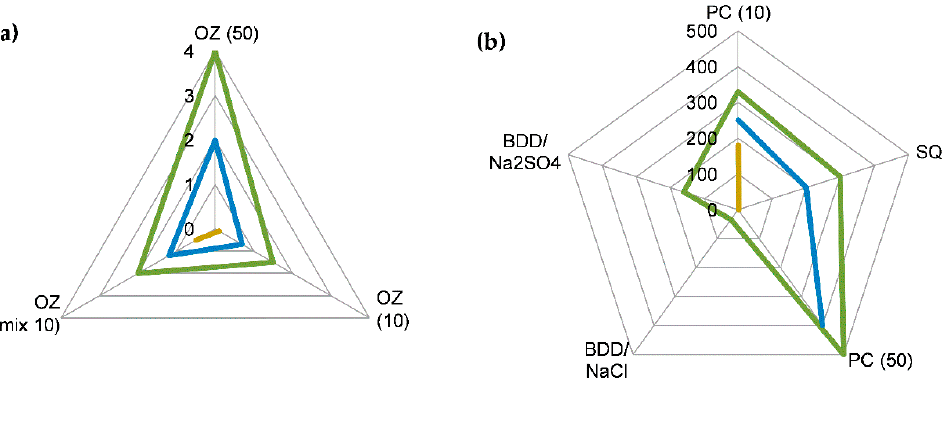
Figure 1. Treatment time for reaching > 95% removal (see Section 2.4) of phenol (PHN), 2,4- dichlorophenol (DCP) and pentachlorophenol (PCP) (TT >95% in min) after treatment with ( a ) ozonation (OZ), and ( b ) photocatalysis (PC), sequential method (SQ), and electrooxidation with BDD anode in NaCl (BDD/NaCl) and Na 2 SO 4 (BDD/Na 2 SO 4 ) (note: numbers in parentheses are initial concentrations in mg/L).